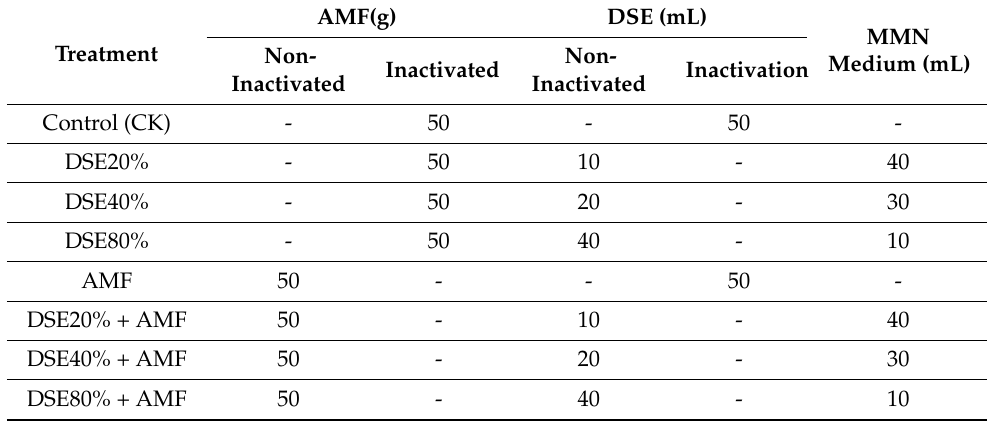
Table 2. Experimental